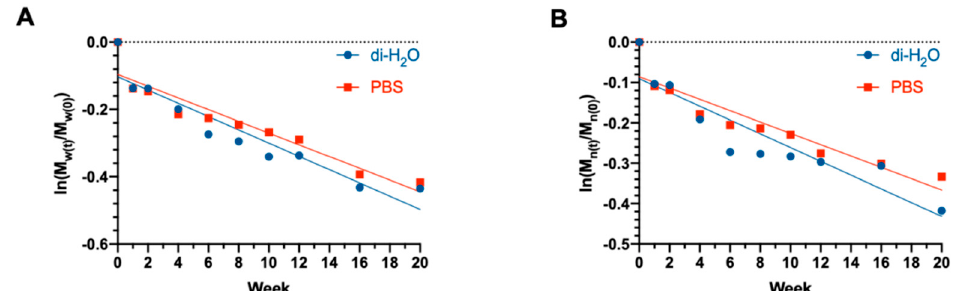
Figure 7. Semi logarithmic representation of the degradation of electrospun PLGA scaffolds up to 20 weeks according to ( A ) M w and ( B ) M n .